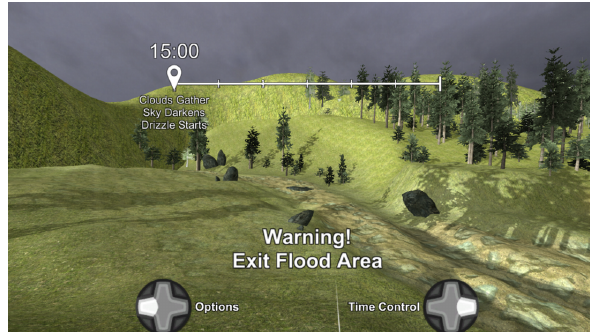
Figure 3. Screenshot from the original Flash